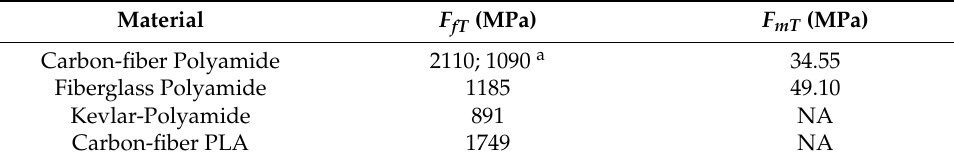
Table 6. Retrieved back-calculated constants for continuous